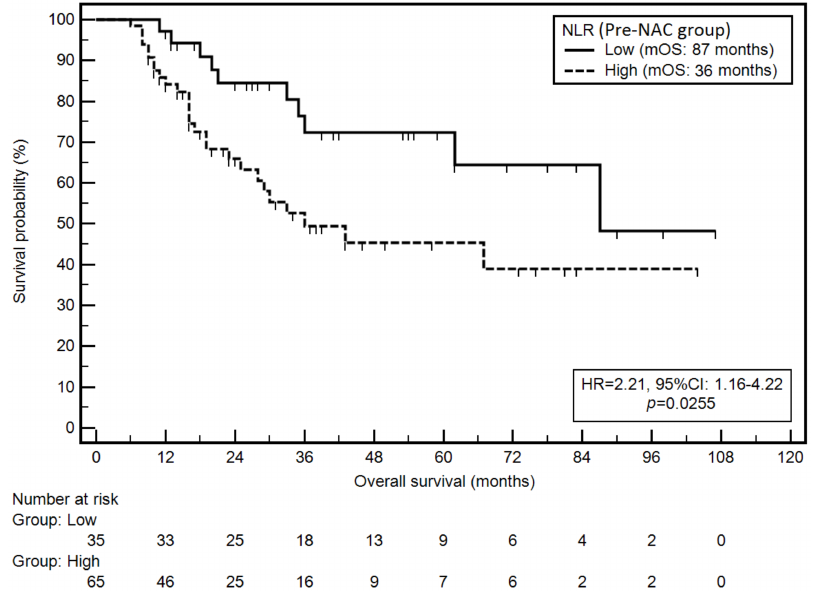
Figure 2. Kaplan–Meier graph representing survival probability in relation to the NLR (pre-NAC group).